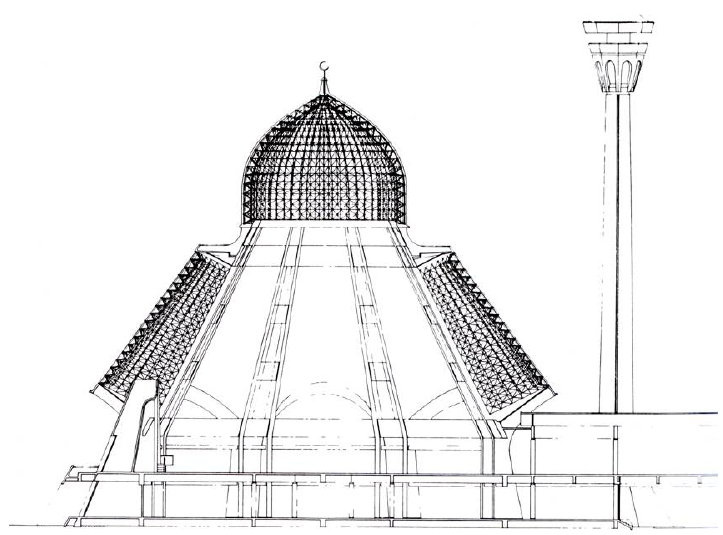
Figure 4: Design drawing by Mick Eekhout of the State Mosque in Kuala Lumpur in 1988, not